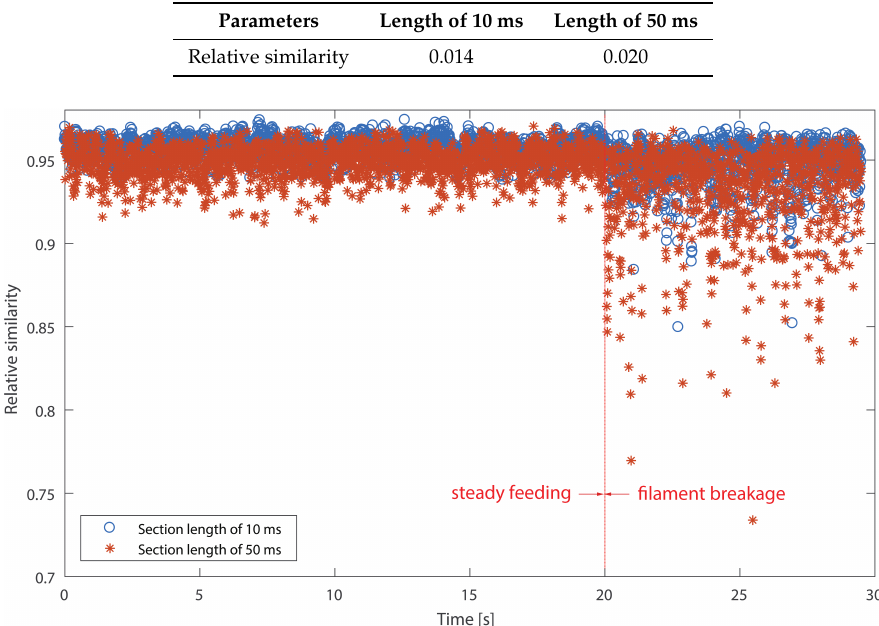
Table 5. CV values of relative similarity for different time sections.